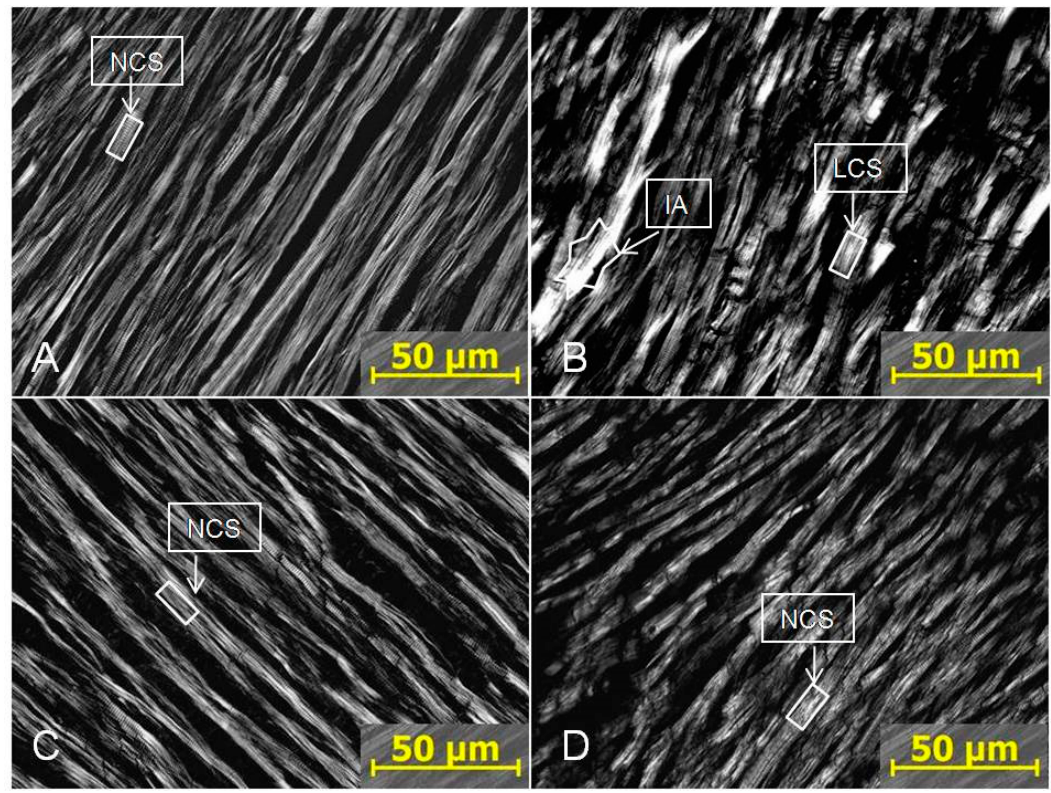
Figure 3. Polarizing microscopy of the rat myocardium. ( A ) Control; ( B ) PTSD; ( C ) IHC; ( D ) PTSD + IHC. Magnification ×400. NCS = normal cross-striation; LCS = loss of cross-striation; IA—ischemic area.